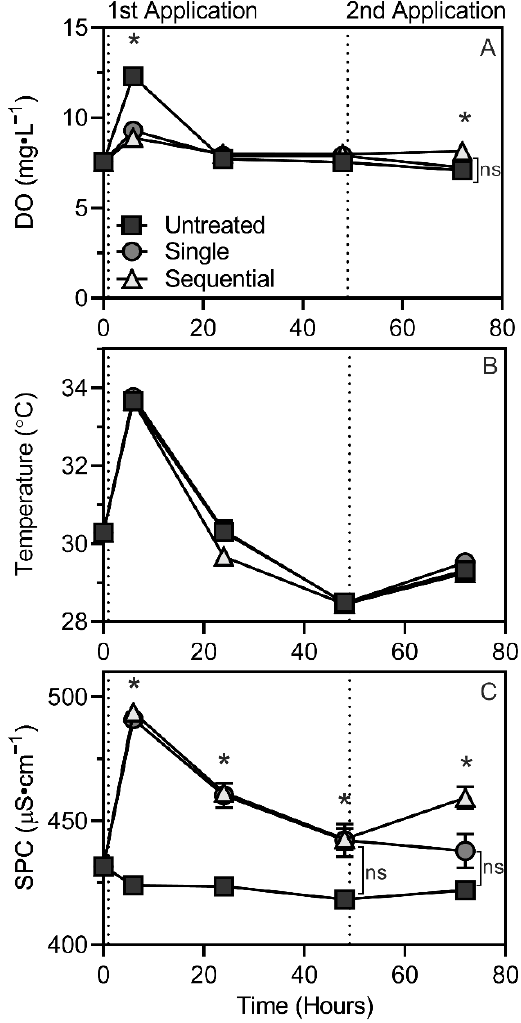
Figure 3. Water quality data following algaecide exposure. Average dissolved oxygen (DO) ( A ), temperature ( B ), and specific conductivity (SPC) ( C ) for untreated (black squares), single application (dark gray circle), and sequential application (light gray triangles) mesocosms. The dotted vertical line represents the first and second algaecide applications. Error bars represent +/ − SEM, n = 4 per treatment. Asterisks represent statistical significance between treated (single and/or sequential) and untreated mesocosms where: * p < 0.05. Individual non-significant (ns) relationships can be identified by brackets. There were no differences between treatments (single and sequential).